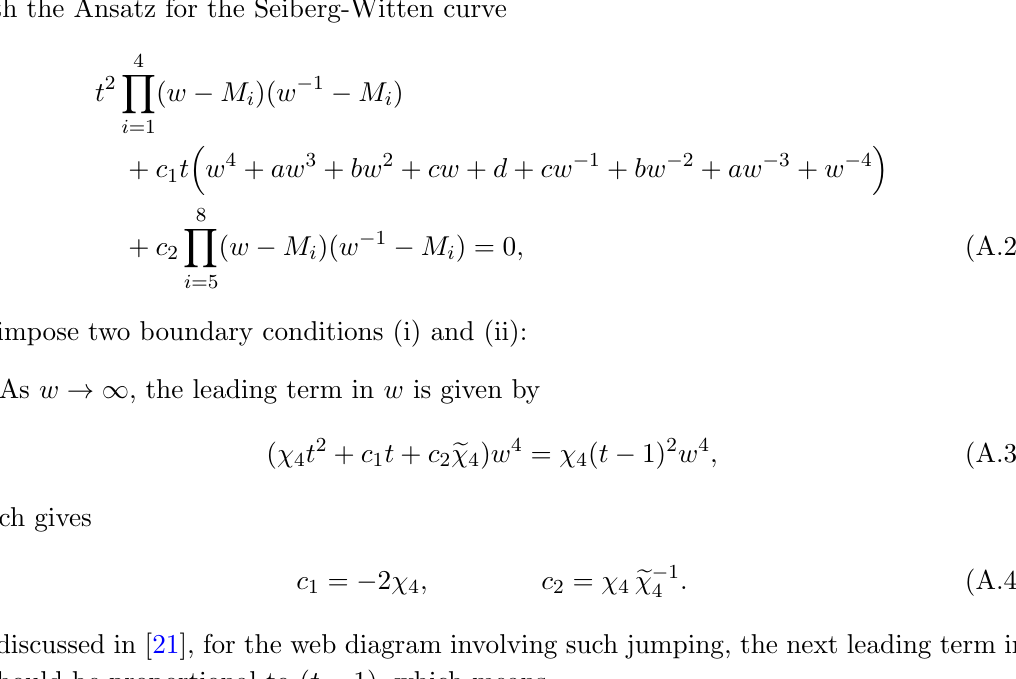
Figure 18. 5d Sp(1) theory with N f = 7 (cid:13)avors in a web diagram with O5-planes. With the Ansatz for the Seiberg-Witten